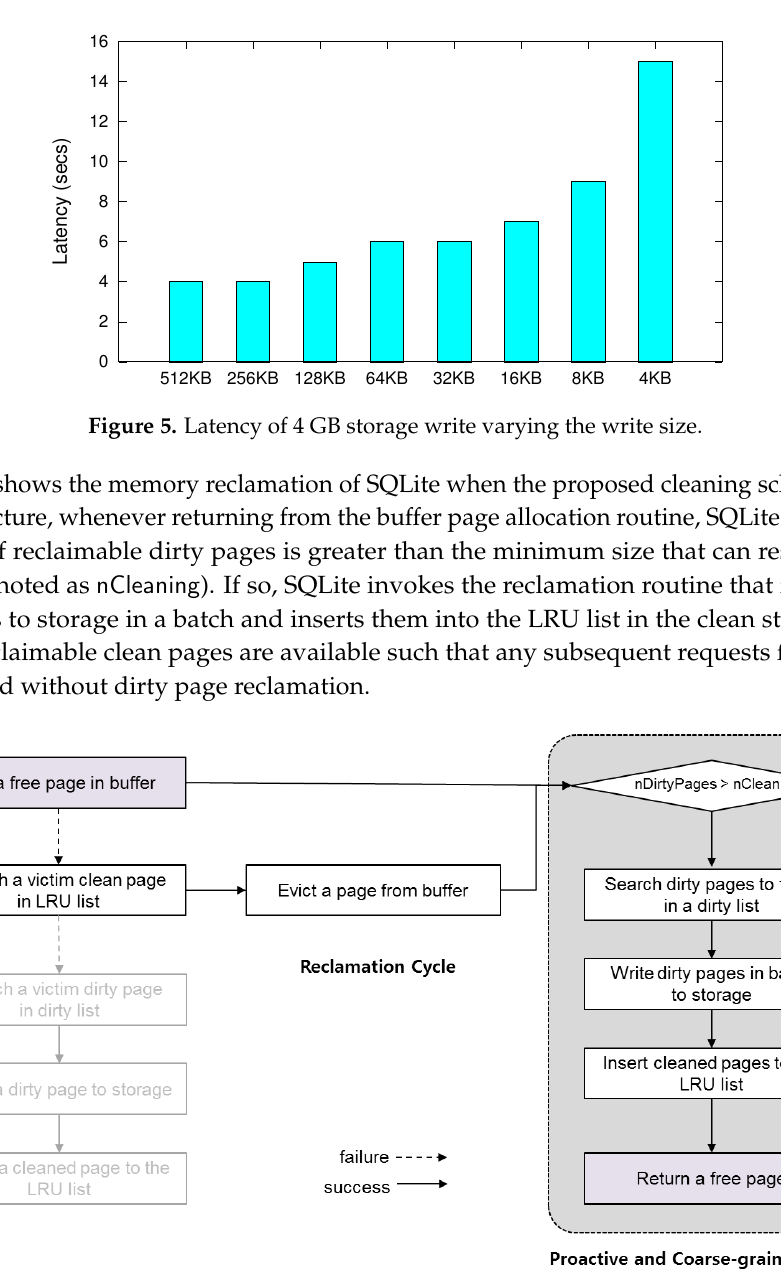
Figure 6. Memory reclamation scheme with proactive and coarse-grained